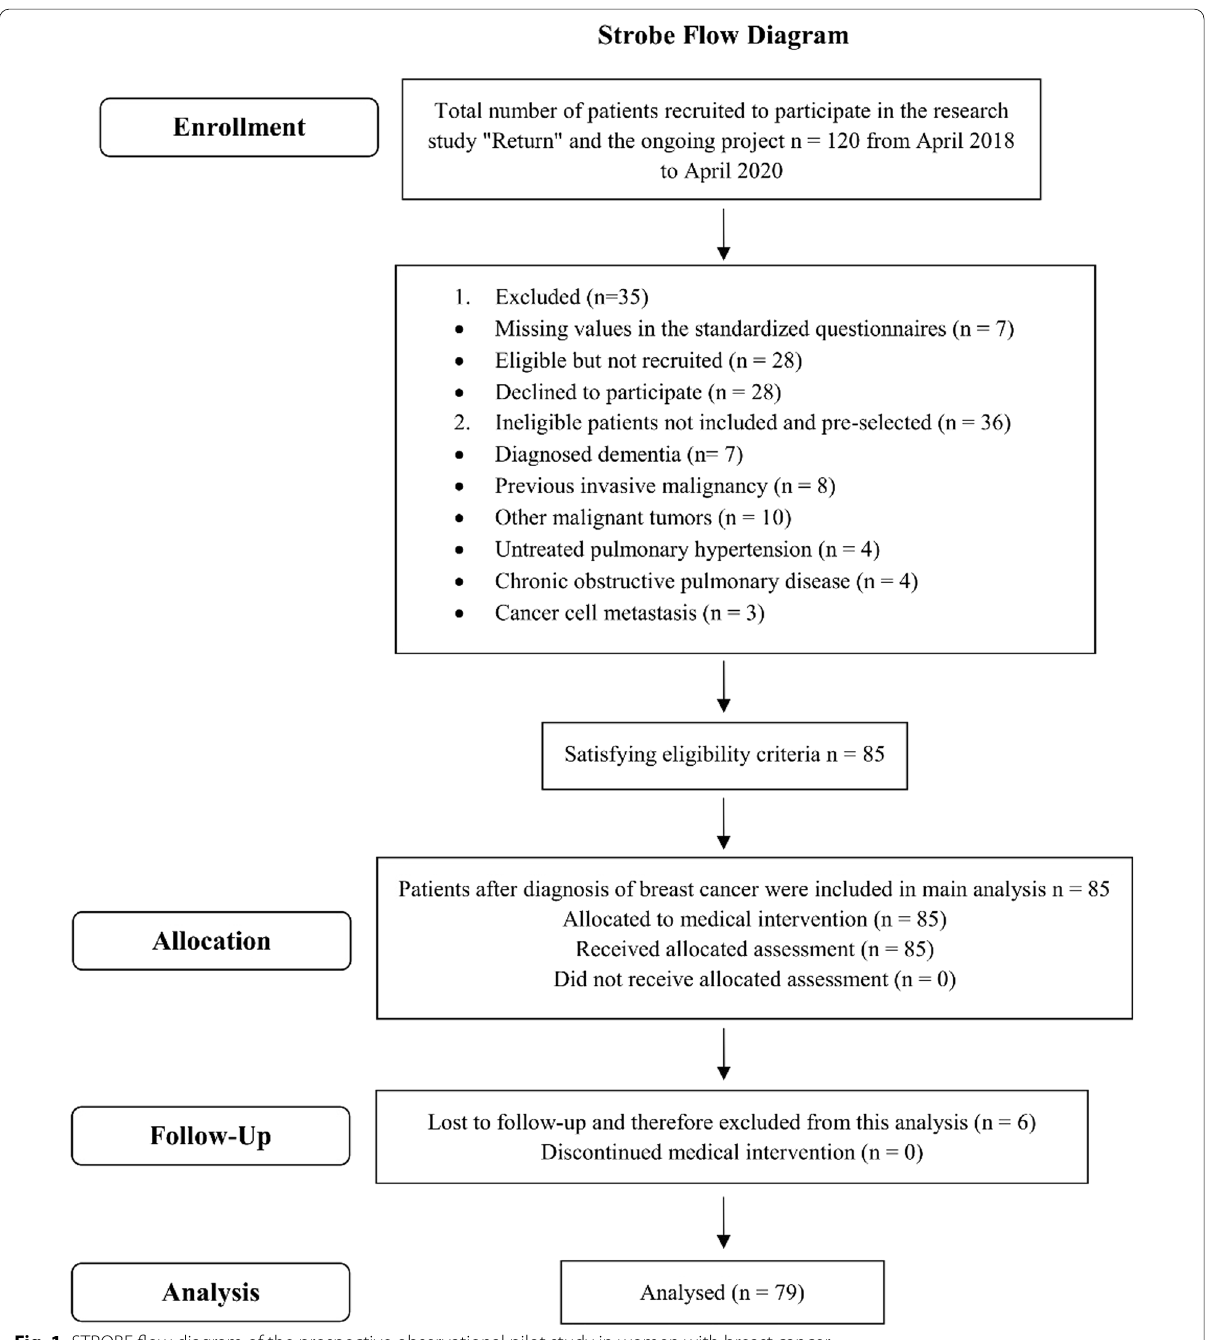
Fig. 1 STROBE flow diagram of the prospective observational pilot study in women with breast